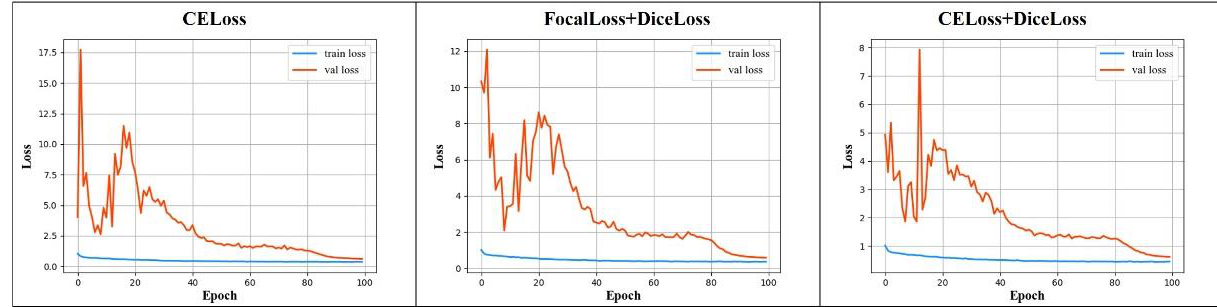
Figure 4. Comparison of DeeplabV3plus loss curve using different loss functions.